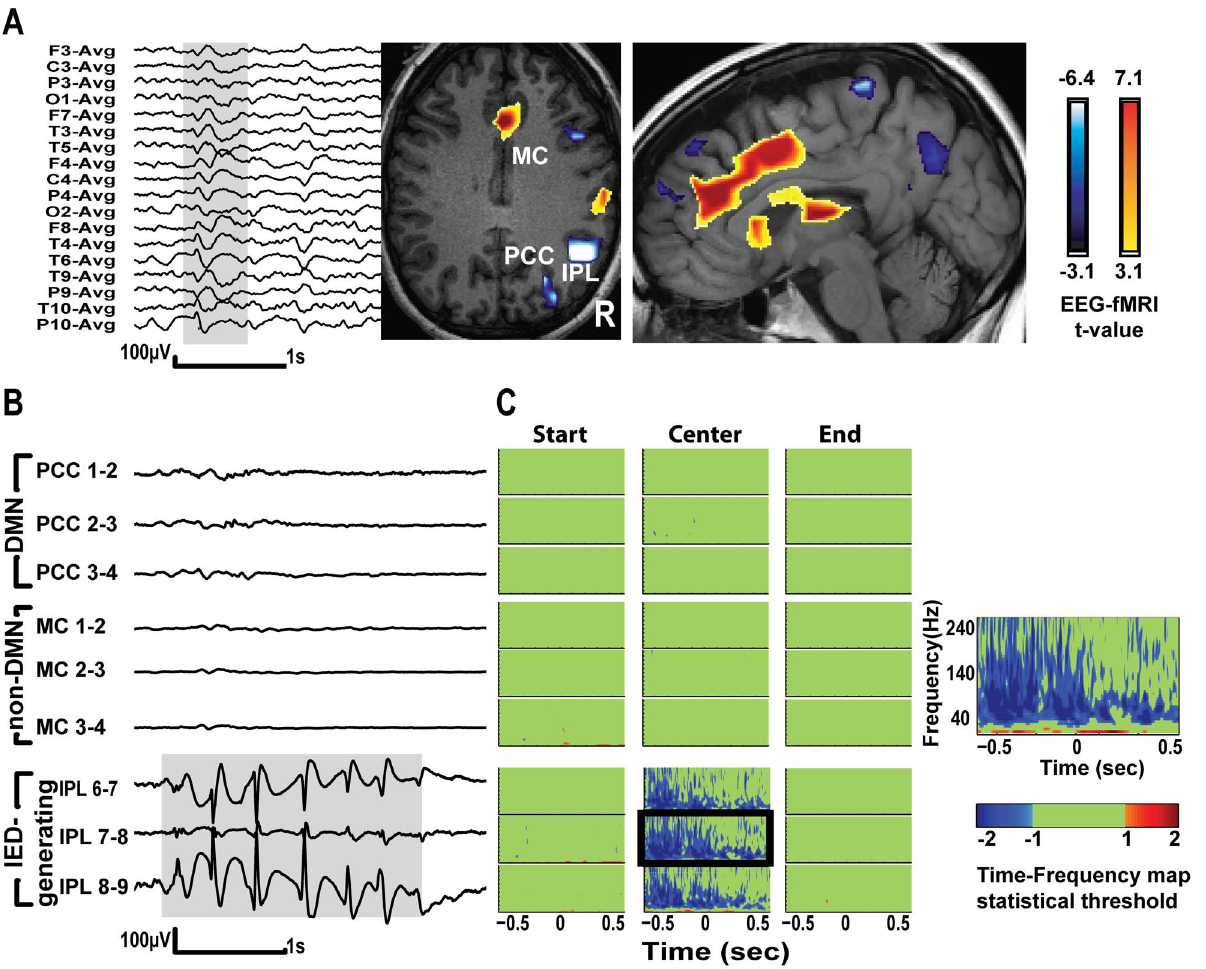
Figure 2. EEG-fMRI results and Time-Frequency (TF) statistical maps of SEEG recordings from patient 3. A – Scalp EEG showing right temporo-parietal IED (spike and slow wave) and the associated BOLD changes. Most significant deactivation (t=-6.7) is in right IPL and concordant with the spike field. Smaller deactivations are in posterior pre-cuneus and frontal and parietal regions ipsilateral to the IED. Activations are in the cingulate gyri, thalami and ipsilateral central region. B - SEEG traces showing typical runs of spike and slow waves in right IPL (lower 3 traces) and in right PCC and middle cingulate (MC). C – TF plots comparing IEDs and baseline in PCC, MC and the channels with IEDs (IPL). The IPL is the spiking channel and part of the DMN. TF maps centered at the center of IED run show decrease in gamma in the channels with IEDs (IPL). Boxed TF map is shown in higher magnification on the right and demonstrates power decrease in 40–160 Hz band, and increase in frequencies , 30 Hz.